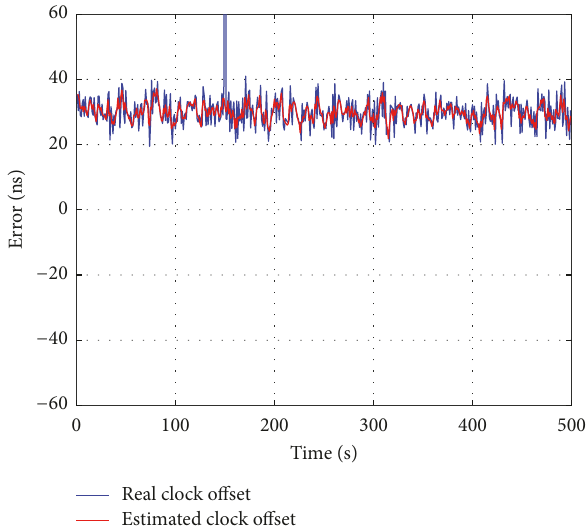
Figure 8: The relative clock offset with big disturbance by improved Kalman